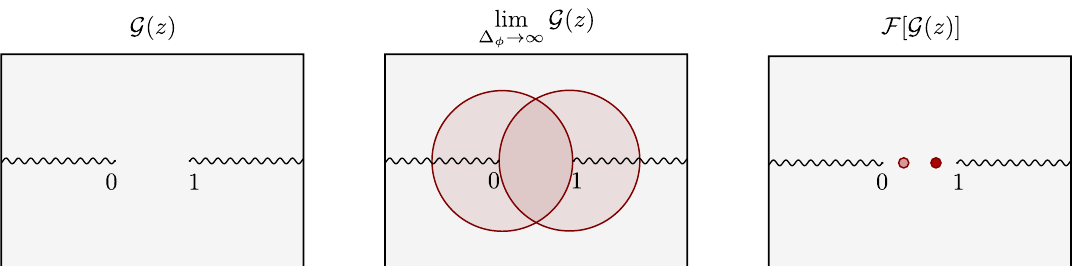
Figure 1 . Schematic derivation of the flat space limit of the correlator. We start on the left with the conformal correlator G ( z ) which has branch points at z = 0 , 1 . We then take the limit when all dimensions are large; this limit is not well defined in certain kinematic regions as shown in the red blobs in the middle panel. Finally we consider the flat space limit where we analytically continue from the safe to the problematic regions to obtain the S-matrix; after this continuation we may encounter singularities in the S-matrix as shown in the right panel for the case of a single bound state